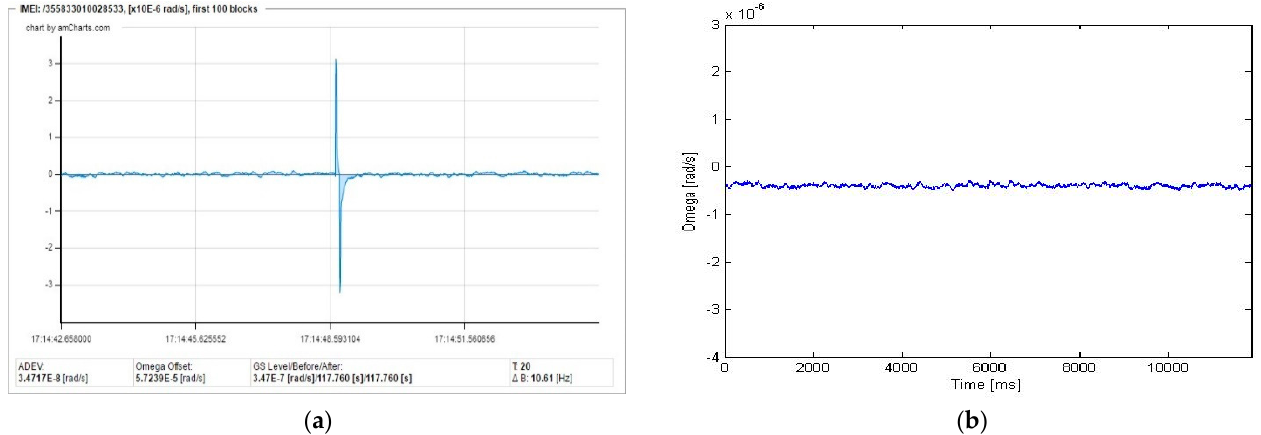
Figure 8. Seismogram (screenshot from dedicated software) recorded by the AFORS-1 at the Ksi ąż Castle seismic observatory, Poland: ( a ) registration of only artefacts, and ( b ) modification of the data collection procedure securing the elimination of artefacts [34].